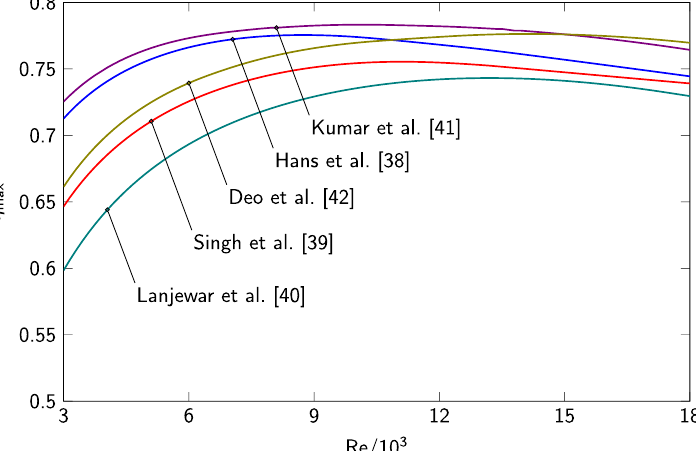
Figure 6. Relationship between η max and Re for absorber plates with straight ribs and ˙ G = 500Wm − 2 .